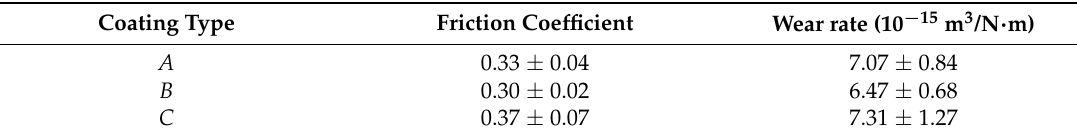
Figure 4. Micrographs of Vickers indentations on transverse section of coatings ( a ) coating ‐ A , ( b ) coating ‐ B , ( c ) coating ‐ C . Table 3. The wear rates of the